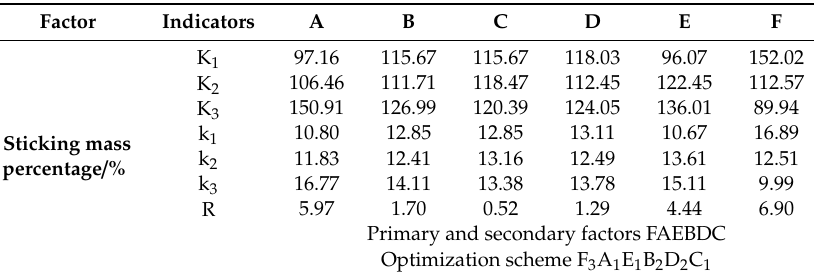
Table 8. Analysis of sticking ratio